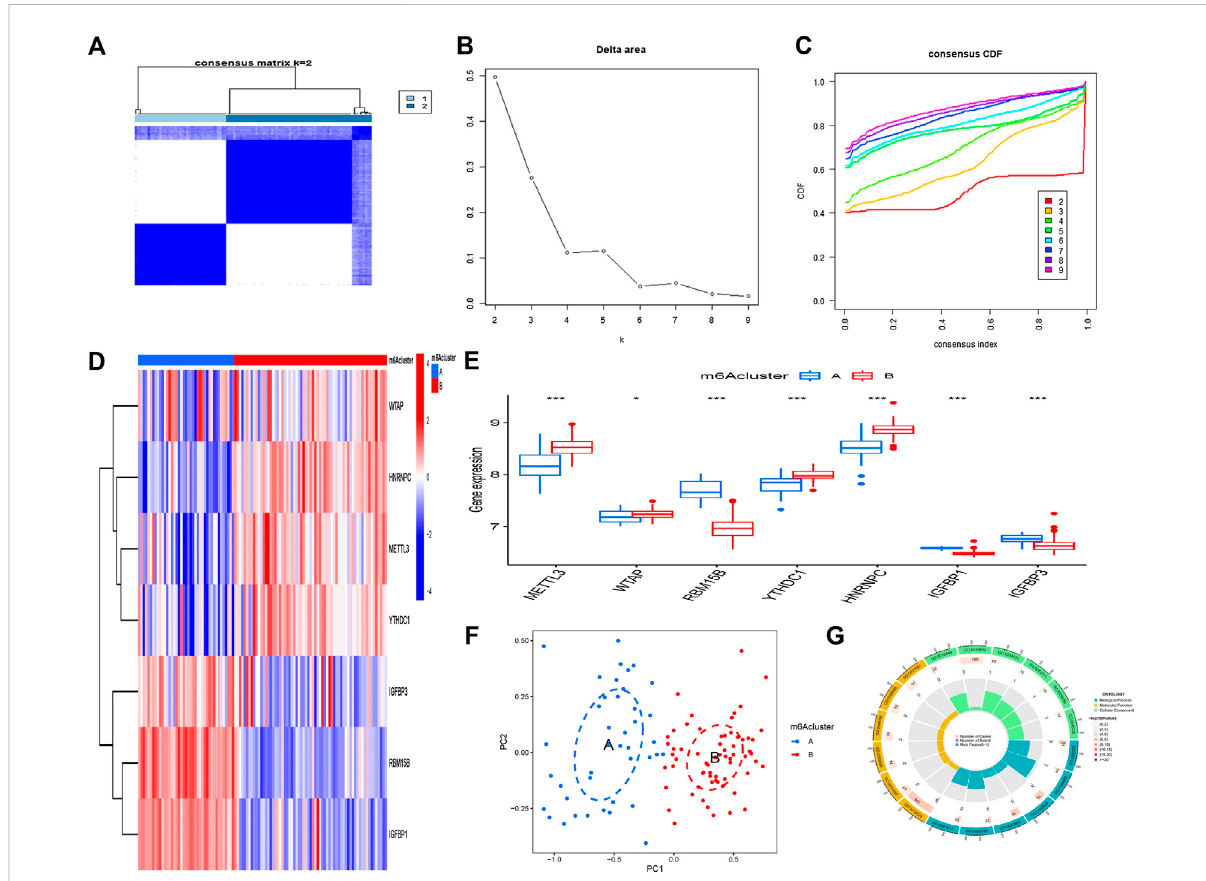
FIGURE 6 Clustering of the seven major m 6 A regulators in OA by consensus. (A) Matrix consensus of the seven major m 6 A regulators for k = 2. (B) The difference of delta area for k = 2 – 9. (C) The area under the CDF curve. (D) Cluster A and B expression heatmaps of the seven important m 6 A regulators. (E) Histogram showing differential expression of the seven major m 6 A regulators in clusters A and B. (F) The expression patterns of the sevenkeym 6 Aregulatorswereanalyzedusingprincipalcomponentanalysis,whichrevealedsigni fi cantdifferencesingenesequencesbetween the two m 6 A patterns. (G) The in fl uence of the 639 m 6 A-related differentially expressed genes (DEGs) on the onset and progression of OA is investigated using gene ontology analysis. * p < 0.05, ** p < 0.01, and *** p <